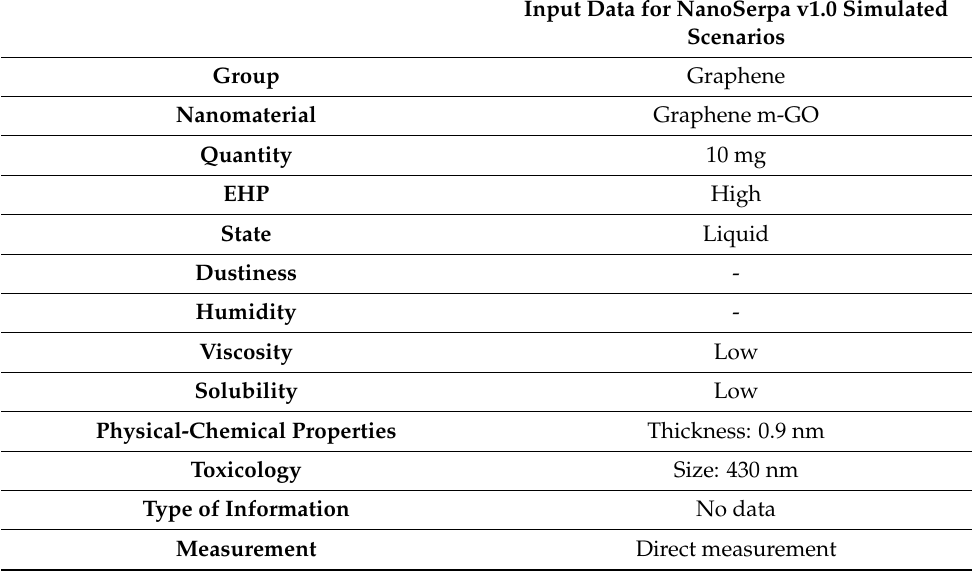
Figure 2. Excerpt from the report generated with the NanoSerpa v1.0 app for a spillage of paint containing graphene during spraying. These results apply only to the exposure area where the events studied have occurred. Table 4. Input data for NanoSerpa v1.0 simulated